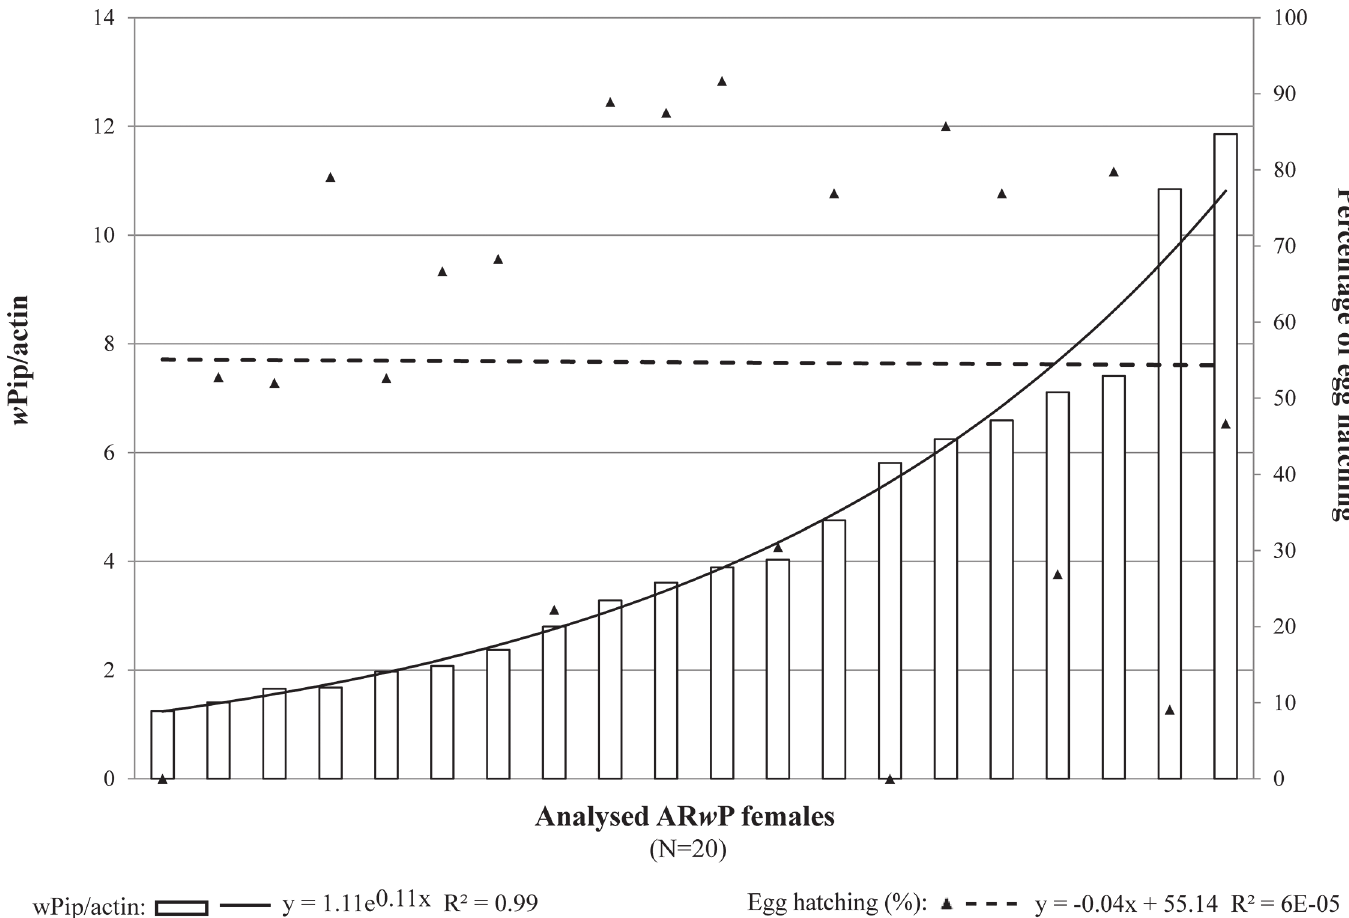
Fig 3. Correlation between percentage of egg hatching in AR w P × AR w P compatible crosses and w Pip Wolbachia density in females. Data trend is displayed via a polynomial trend-line together with the associated function.